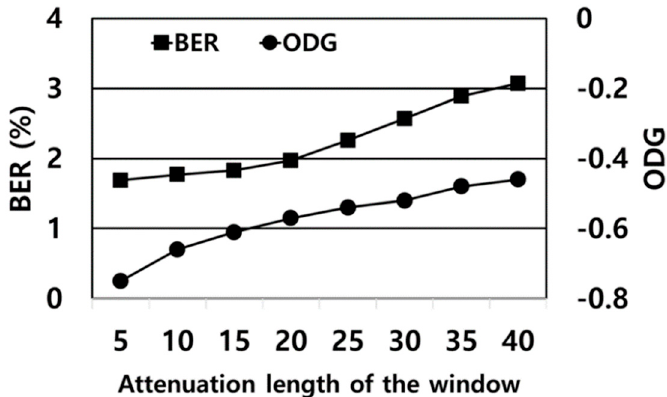
Figure 12. ODG and BER values under various attenuation lengths of the window.